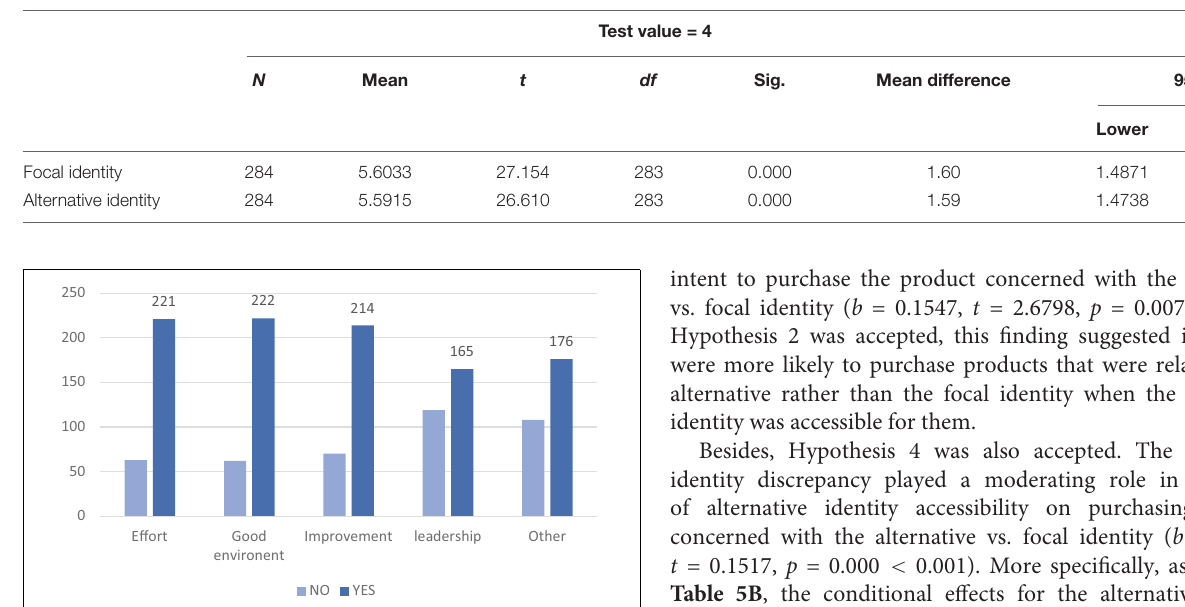
TABLE 3 | Results of participants’ perception about focal and alternative identity in each scenario.